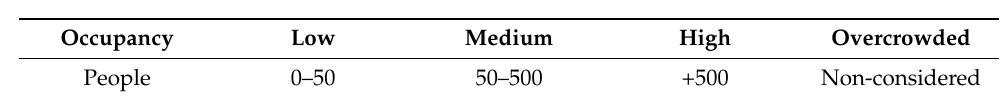
Table 3. Occupancy in a commercial environment.